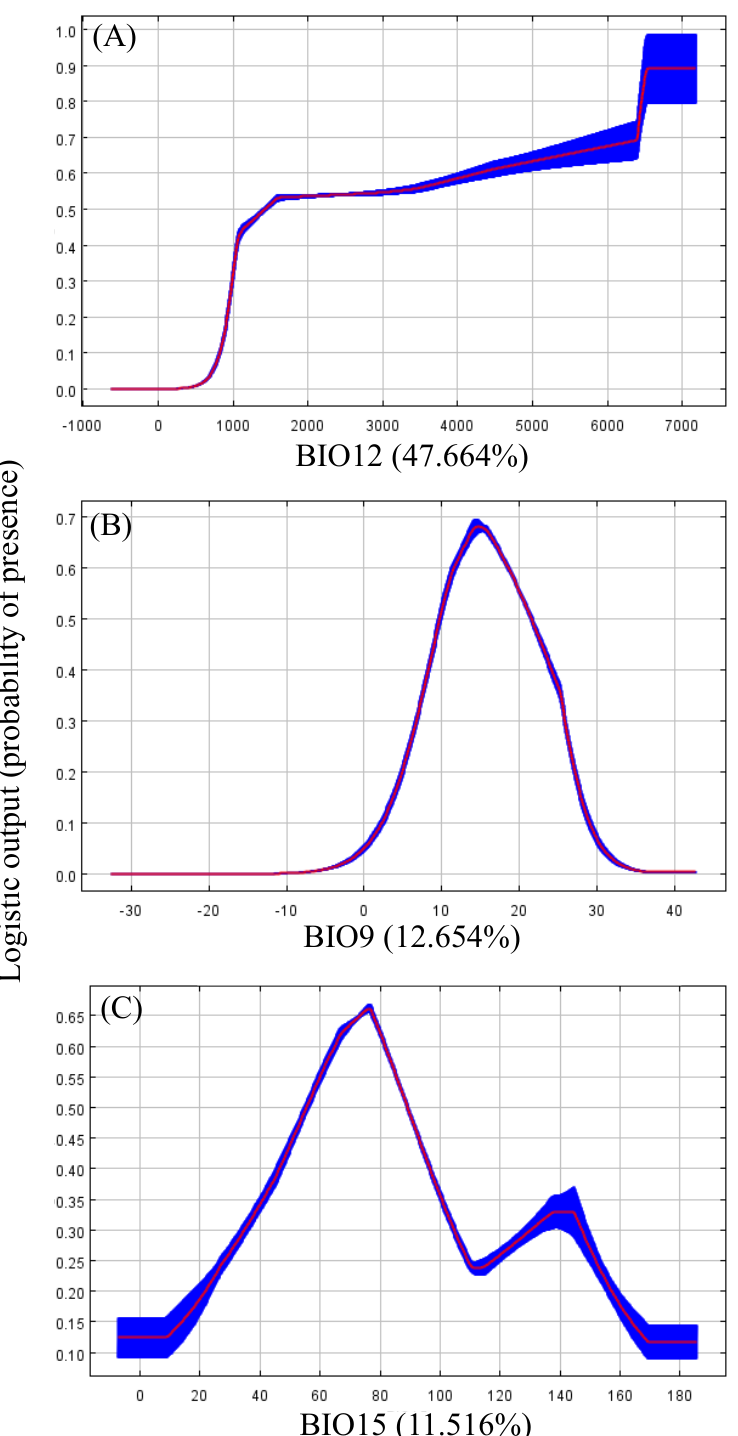
Figure 3. Response curves of three environmental variables greatly explain the spatial distribution of N. chinensis . ( A ), annual precipitation; ( B ), mean temperature of the driest quarter; ( C ), precipitation seasonality.